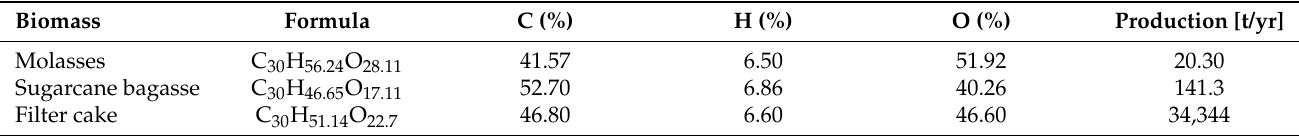
Table 1. The biomass used in the case factory under study (adapted from Equation